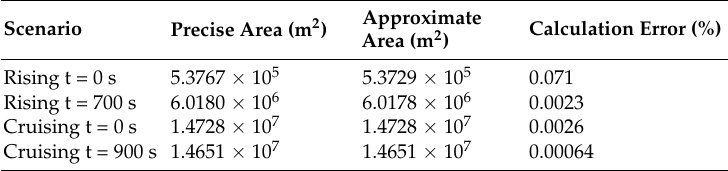
Table A1. Examples of Area Calculation Error of the Scattering